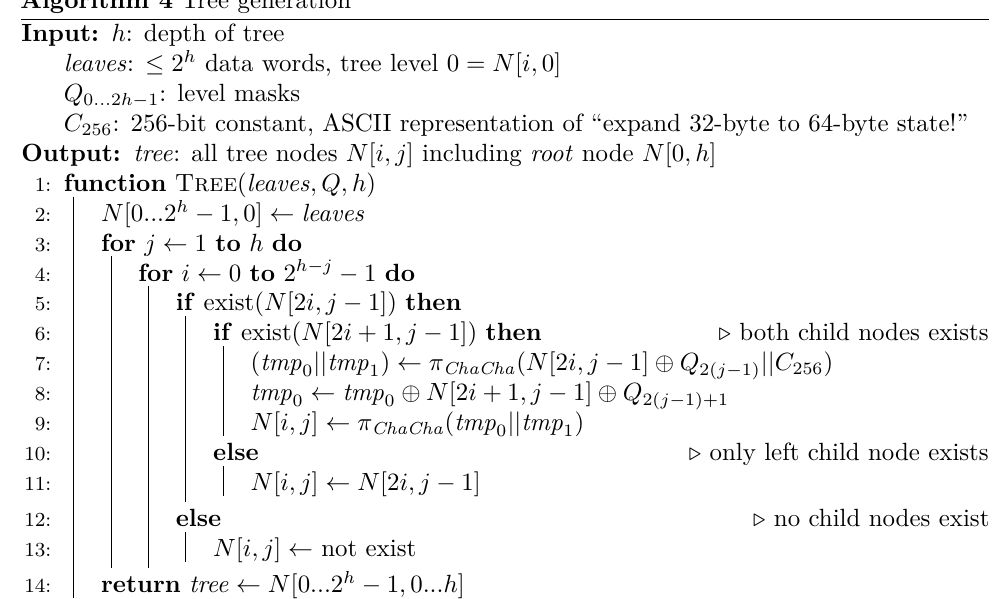
Algorithm 4 Tree generation